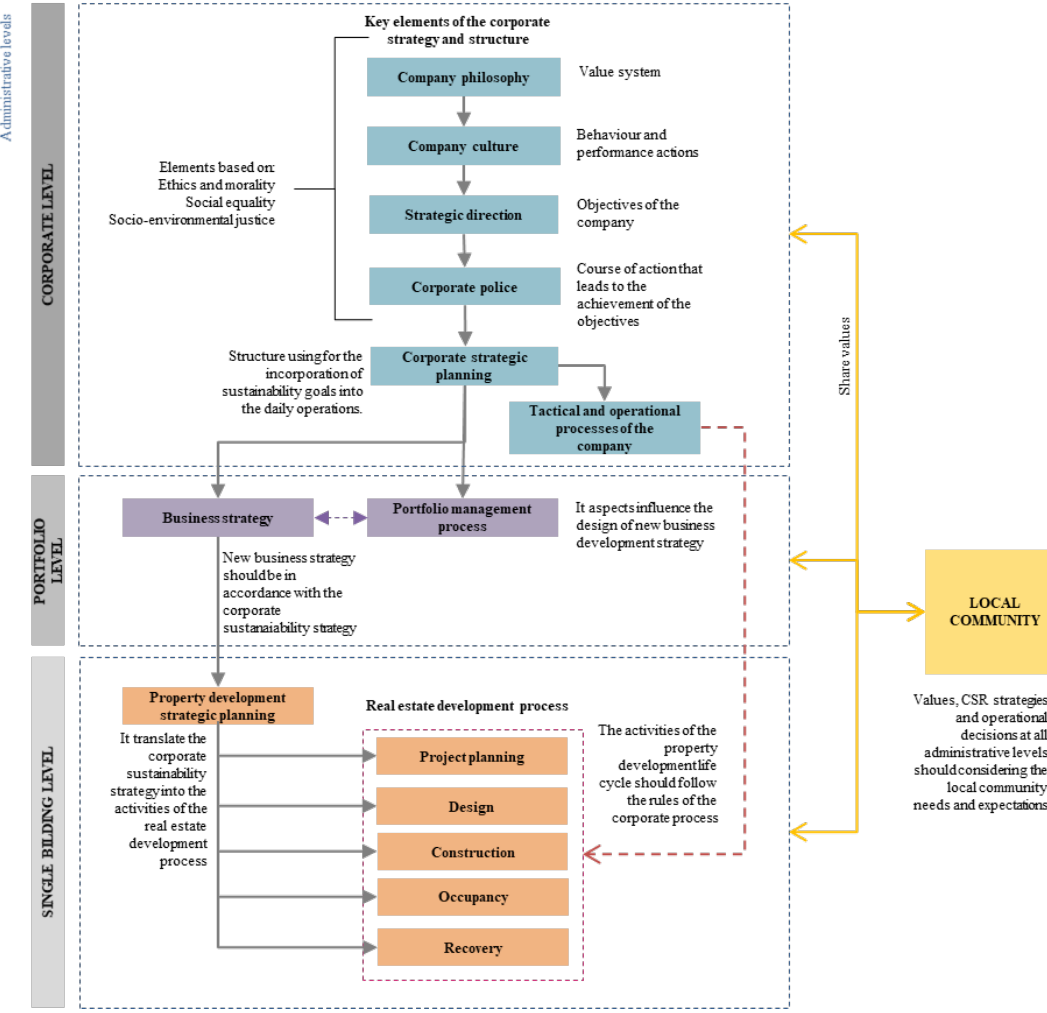
Figure 4. The interrelation between the company’s key elements for the creation of a sustainable information flow (source: elaborated by the